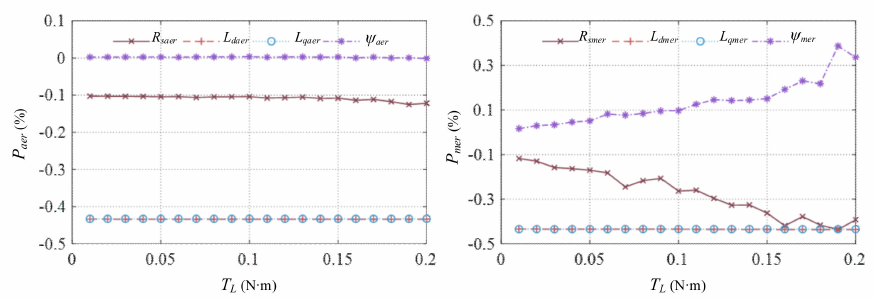
Figure 11. Identification accuracy at different loads.